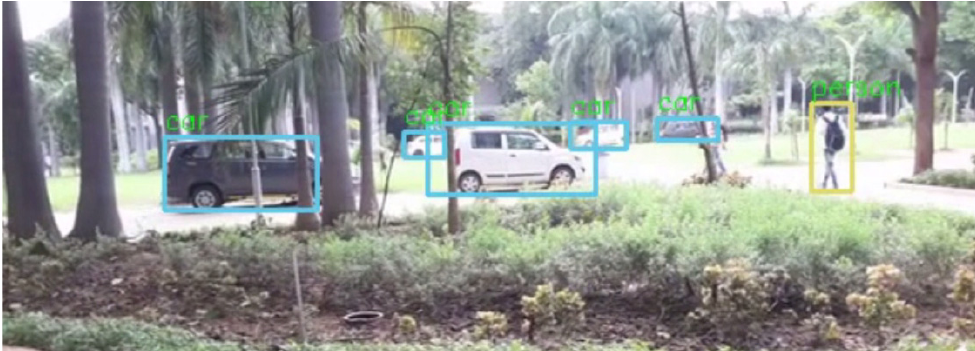
Figure 17. Object detection and recognition from a video sequence (Example 2).